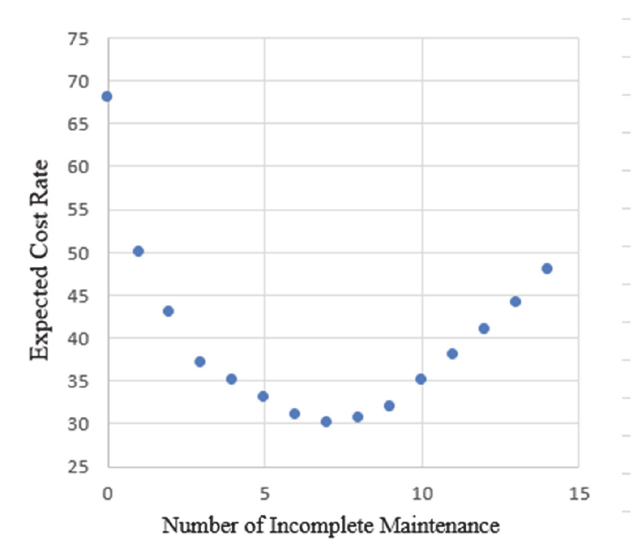
Fig. 8 . Values of expected cost rates according to the changes in the number of